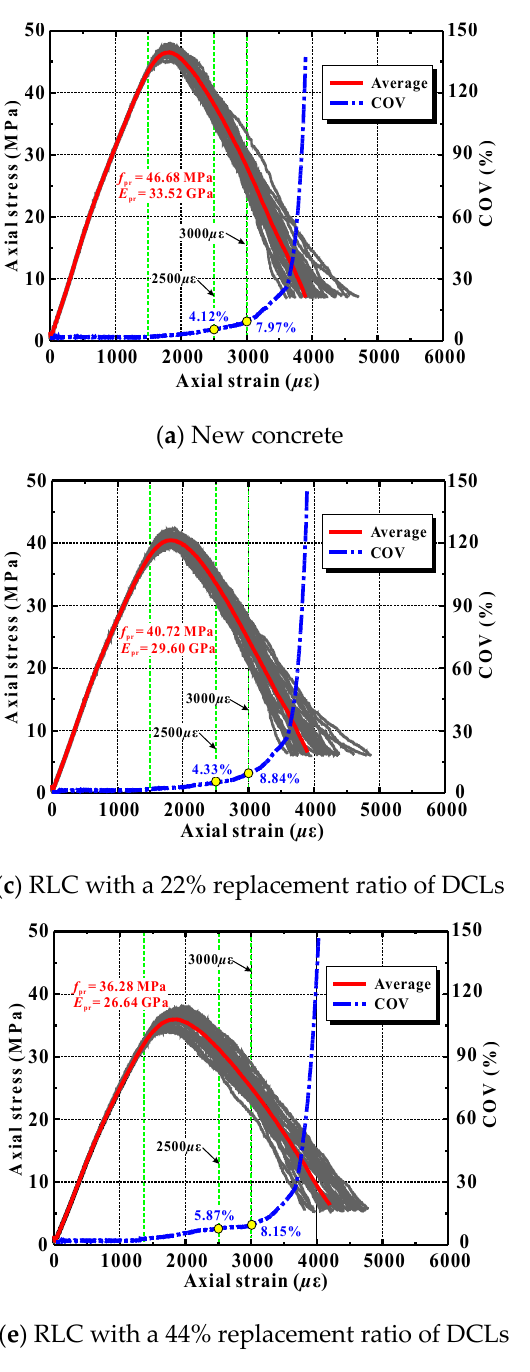
Table 9. Statistical characteristics of concrete stress. COV—coefficient of variation.